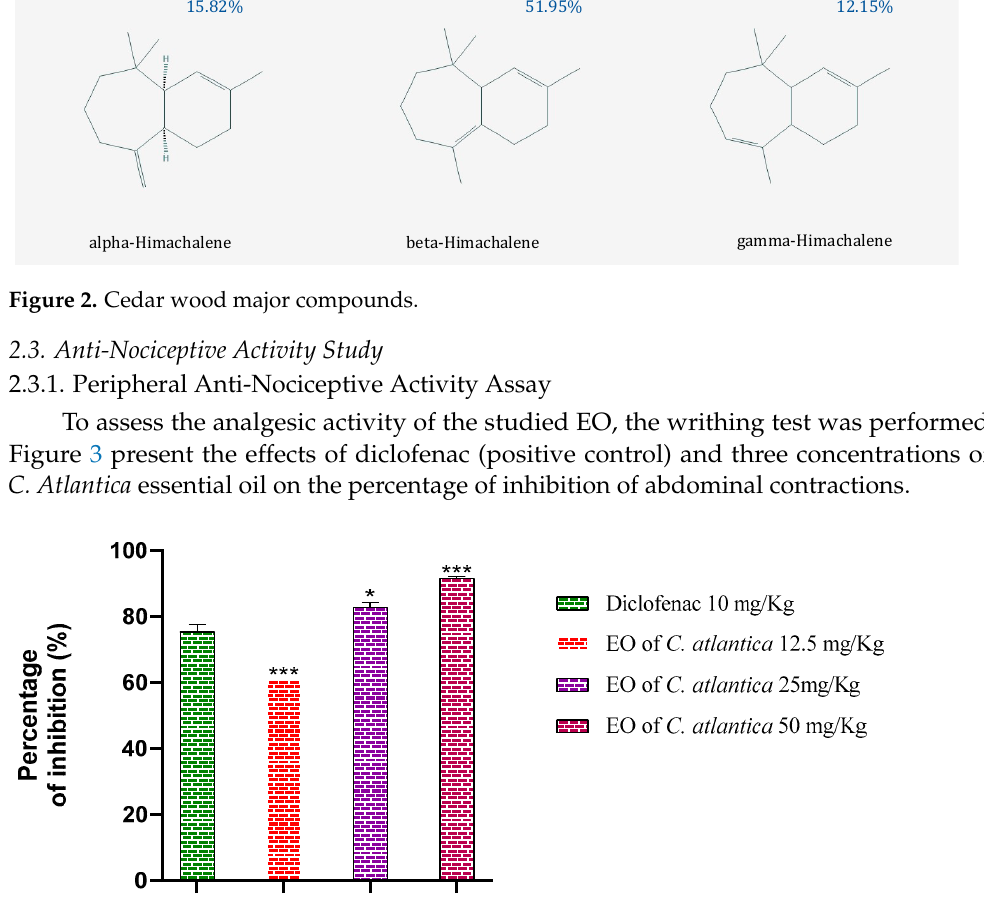
Figure 3. Analgesic activity of the essential oil of C. Atlantica by the writhing method. Values are expressed as mean ± SD ( n = 5). * p < 0.05, *** p < 0.001 compared to diclofenac. After acetic acid injection to the mice, abdominal cramps are recorded after 30 min.